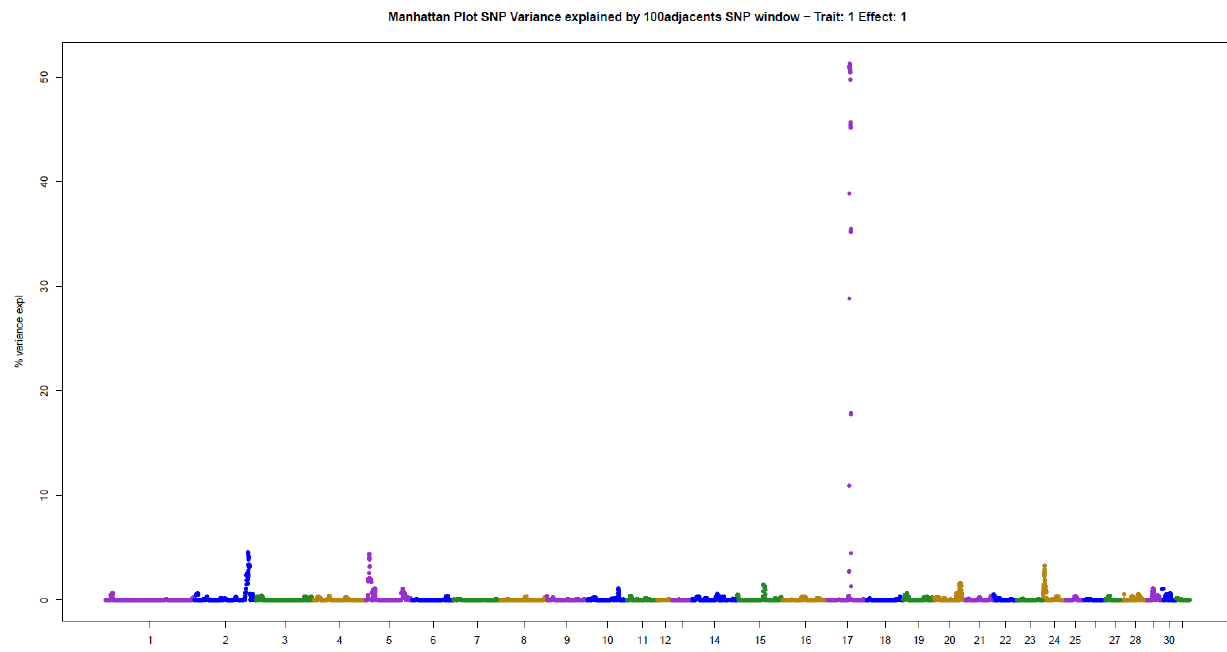
Figure 2. Manhattan plot of hair whorl position on the head of Quarter Horses. The y-axis indicates the proportion of variance explained by windows of 100 adjacent SNPs. The chromosomes are given on the x-axis.